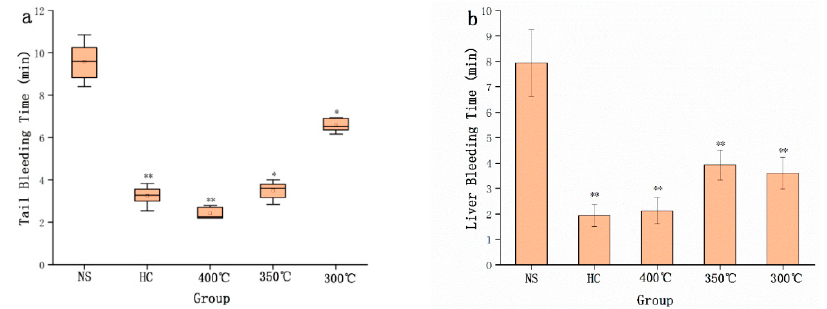
Figure 1. Haemostatic time in mouse tail amputation and liver scratch models: ( a ) Tail amputation ( n = 8) and ( b ) liver scratch ( n = 8) models treated with normal saline (NS), haemocoagulase (HC), and STC ‐ NPs produced at 400 °C, 350 °C, and 300 °C. ** p < 0.01 and * p < 0.05 compared to the control group ( n = 8).